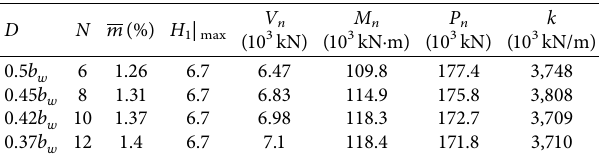
Table 5: TLWD strength performance under single-layer